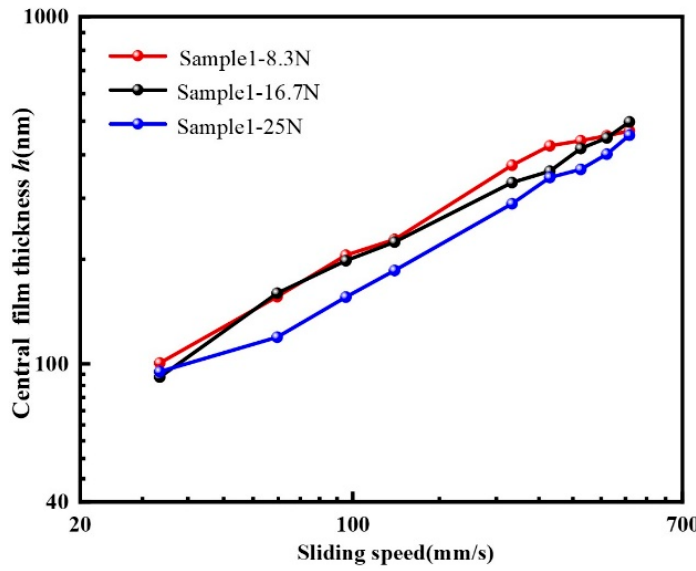
Figure 8. Comparison of central film thickness of sample 1 under different loads.